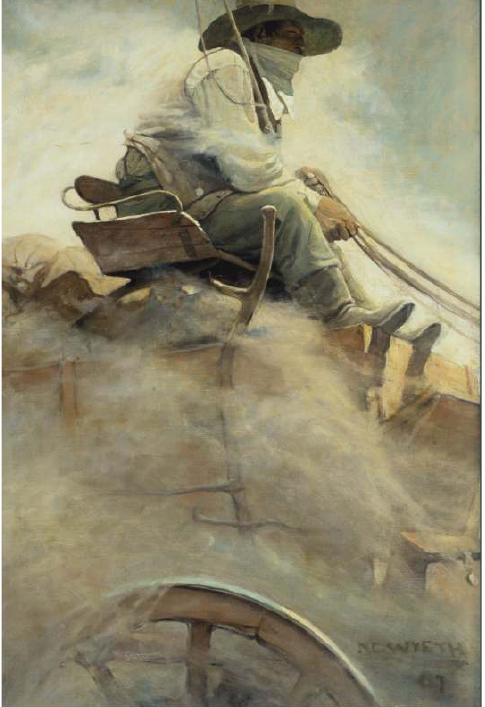
Figure 5. N. C. Wyeth, The Ore Wagon . Oil on canvas